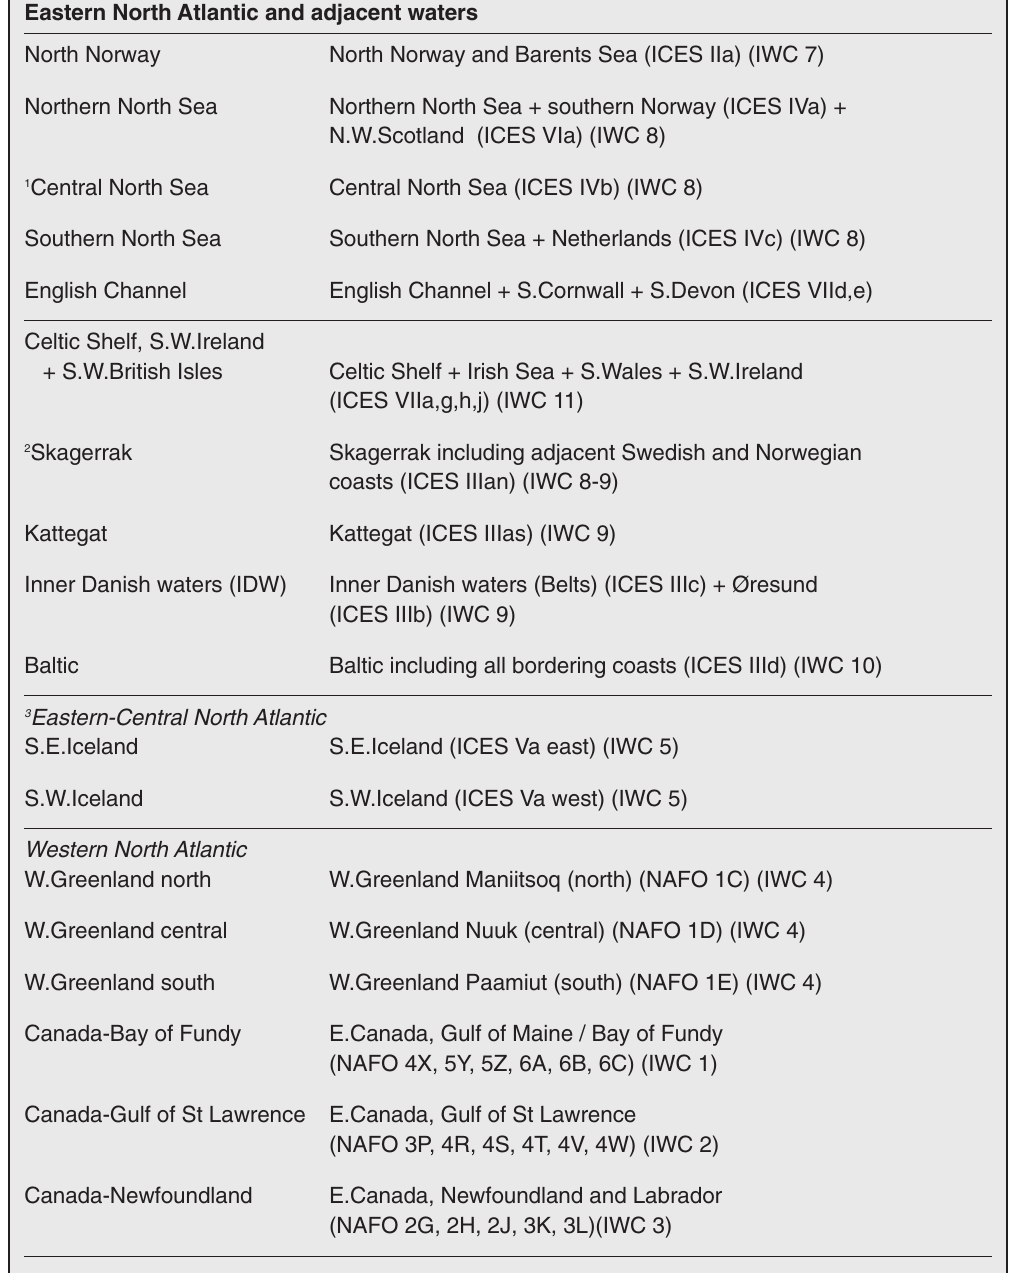
Table 2. Some proposed regional / putative population boundaries within the North Atlantic, with reference to ICES areas, and Gaskin (1984) as revised by IWC